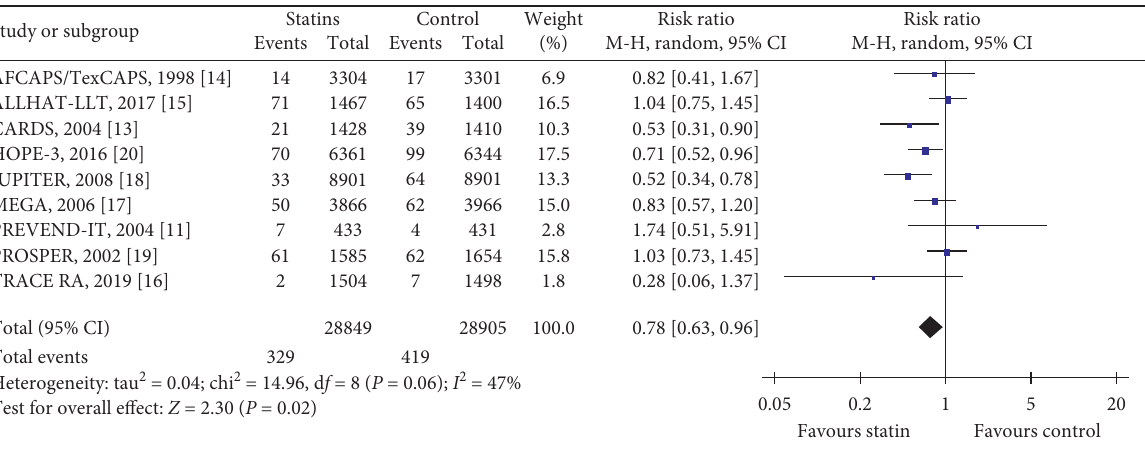
Figure 4: The occurrence of major cerebrovascular events in the included trials.